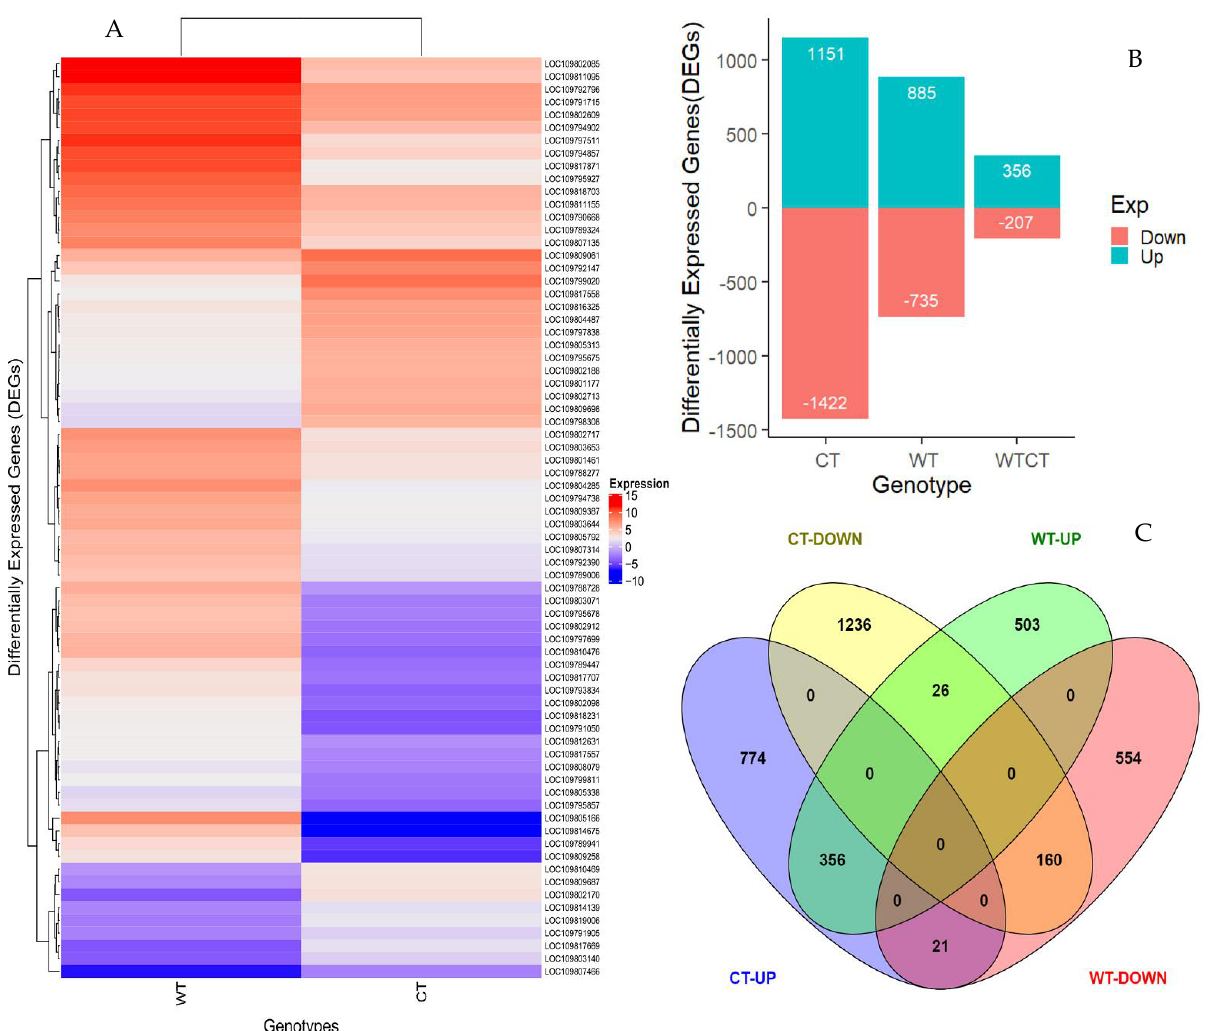
Figure 2. Differentially expressed genes in susceptible cultivated (CT) and resistant wild (WT) pigeonpea genotypes upon pod borer infestation. ( A ) Heatmap showing differentially expressed genes between CT and WT after 24 h of pod borer infestation. ( B ) Bar graph showing the disparate expression of genotype-specific and shared genes between CT and WT. ( C ) Cross-comparison Venn diagram showing the number of differentially expressed genes in CT and WT.